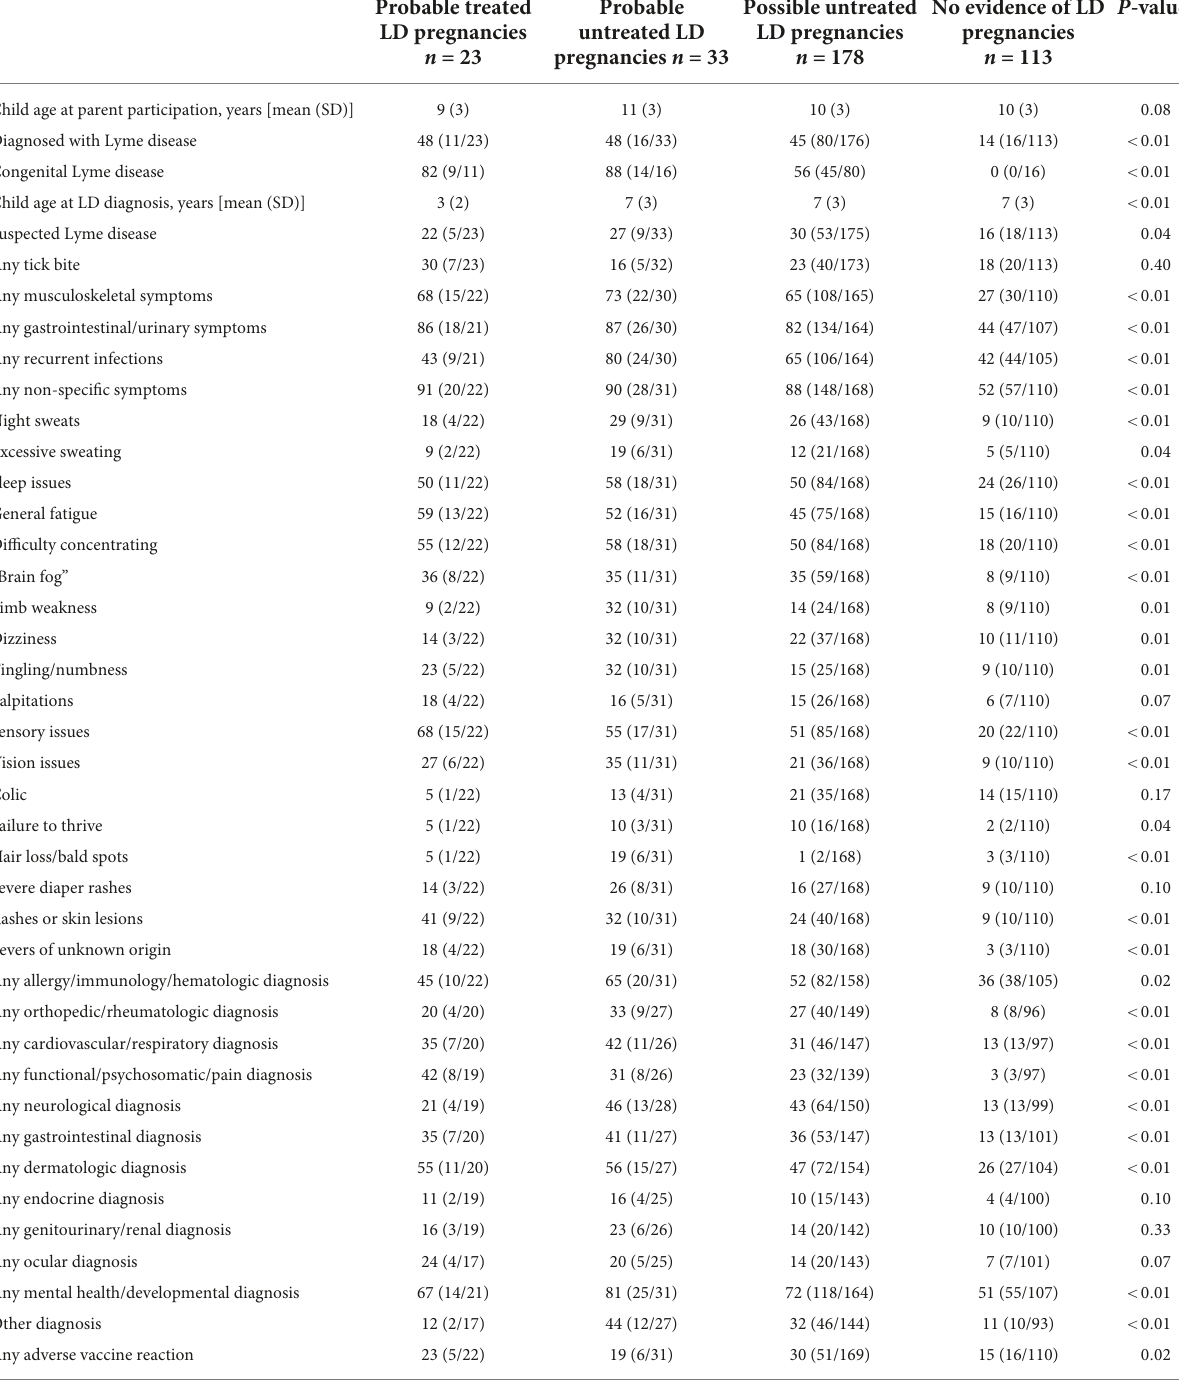
TABLE 7 Outcomes in children between the ages of six and 15 by participant/parent LD status.